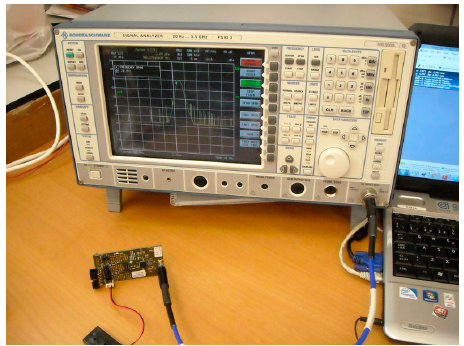
Figure 10. Test of output power level for the output signal of mote.